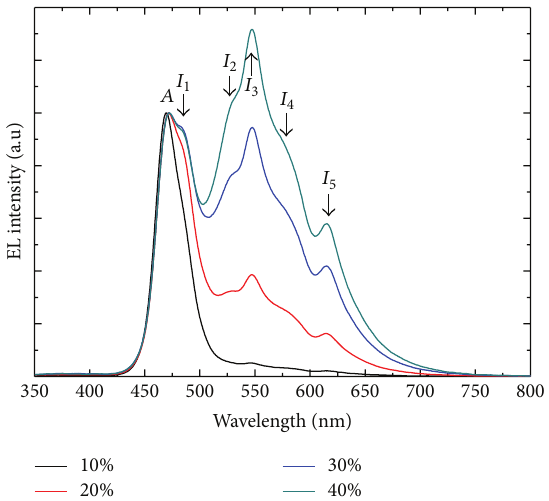
Figure 4: EL spectra obtained with different incorporation amount.